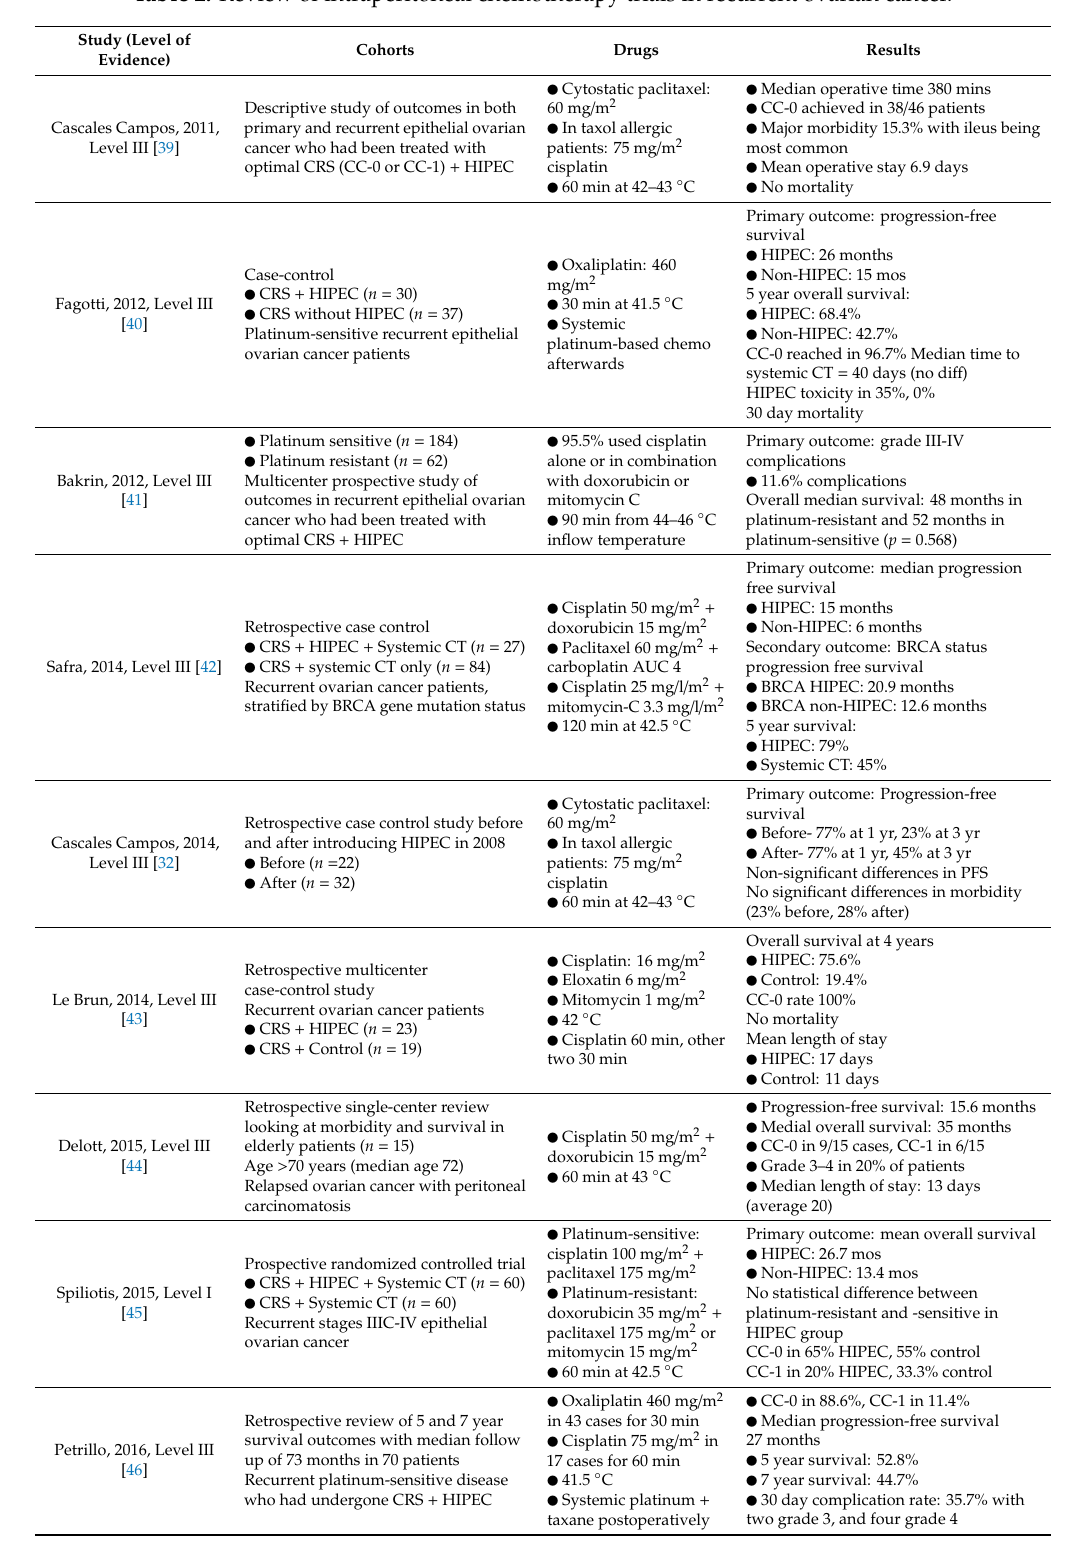
Table 2. Review of intraperitoneal chemotherapy trials in recurrent ovarian